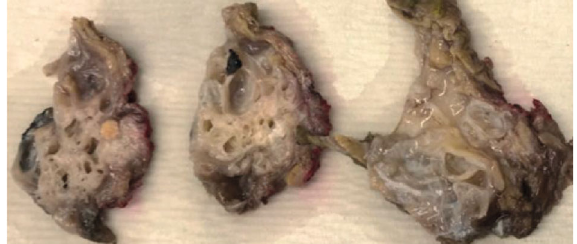
Figure 2: Serial sections of the multilocular cystic lesion in the head of the pancreas showed variable-sized cysts fi lled with clear fl uid, and the cystic wall was smooth without any solid or papillary areas.